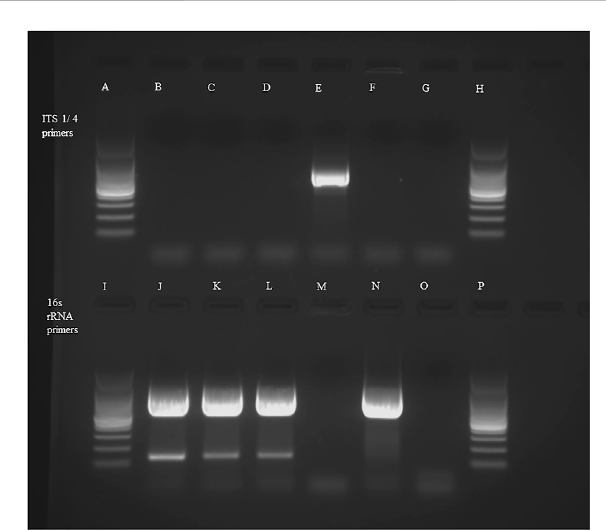
FIGURE 12 PCR with fungal-speci fi c ITS 1/4 primers: (A) - 100 bp ladder, (B) - DNAisolate( fi rstreplicate), (C) -DNAisolate(secondreplicate), (D) -DNA isolate (third replicate), (E) -fungal control ( Colletotrichum coccodes ), (F) - bacterial control ( Streptomyces scabies ), (G) -negative control (water), and (H) - 100 bp ladder. PCR with bacterial-speci fi c 16s rRNA primers: (I) - 100 bp ladder, (J) - DNA isolate ( fi rst replicate), (K) - DNA isolate (second replicate), (L) - DNA isolate (third replicate), (M) -fungal control ( C. coccodes ), (N) - bacterial control ( S. scabies ), (O) - negative control (water), (P) - 100 bp